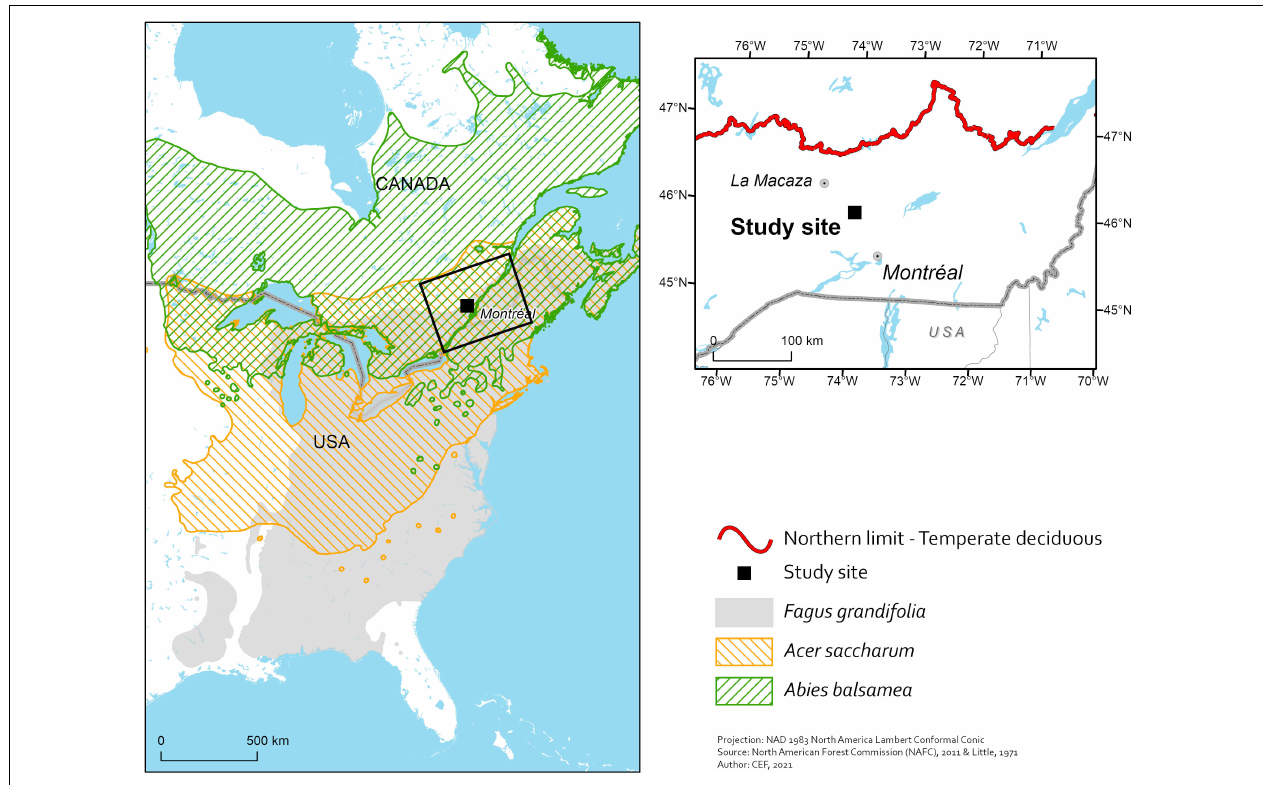
FIGURE 1 | Location of Station de biologie des Laurentides (Study site) in southern Quebec, Canada, along with the distributions of sugar maple ( Acer saccharum ), American beech ( Fagus grandifolia ) and balsam fir ( Abies balsamea ) (left-hand map) as well as the northern limit of temperate deciduous forests (right-hand map).